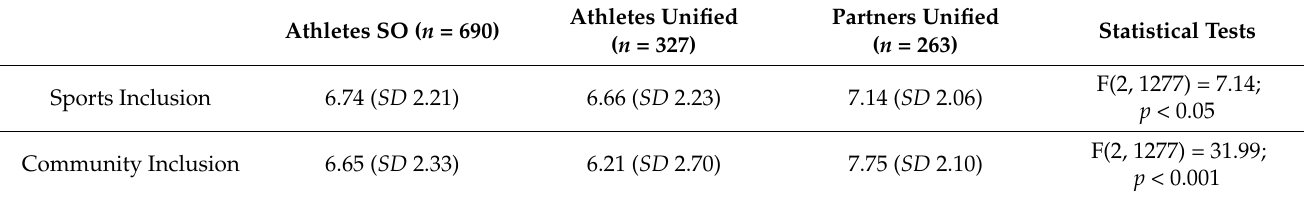
Table 6. The mean and standard deviations for a count of ‘Yes’ ratings for the athletes and partners. Athletes SO ( n = 690)